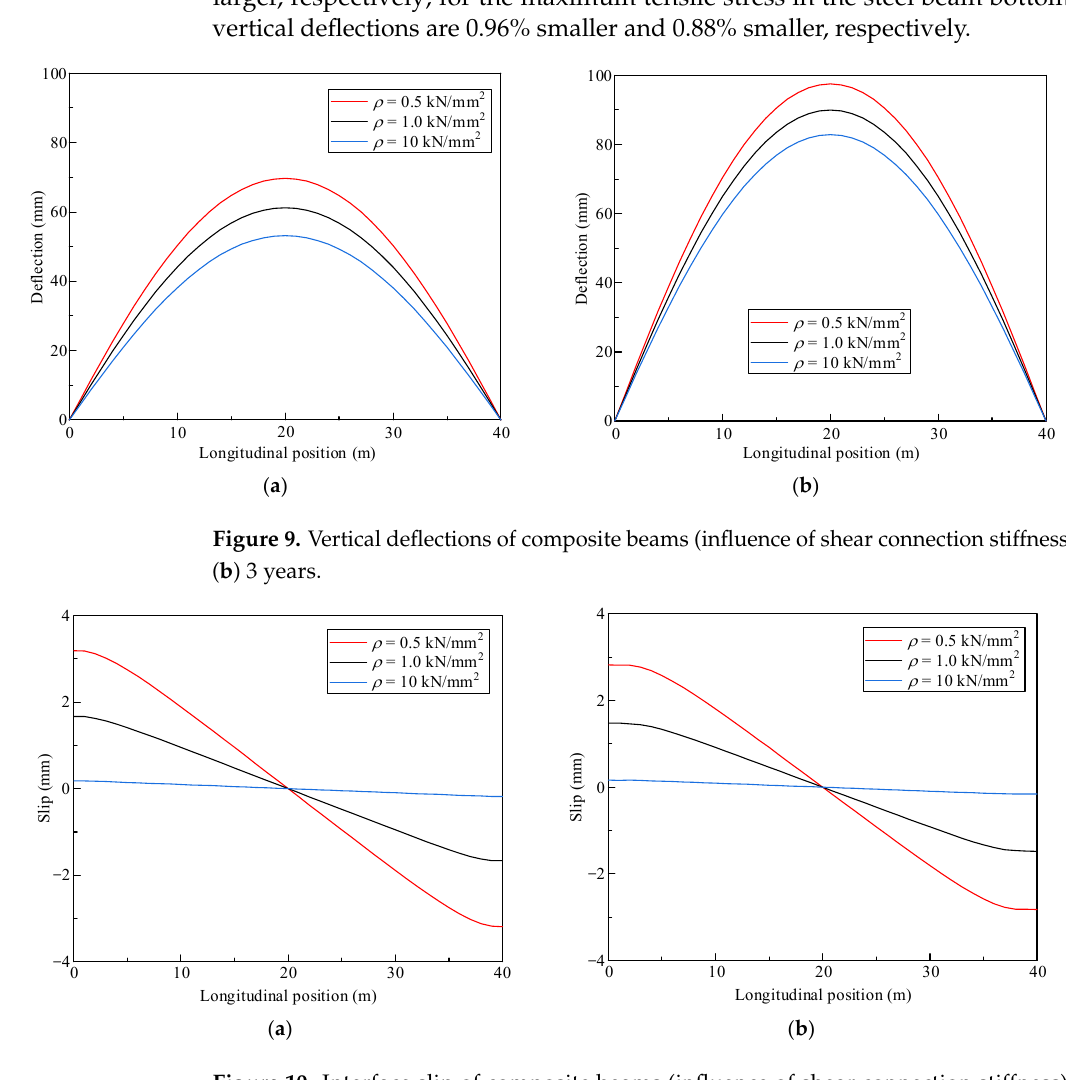
Figure 10. Interface slip of composite beams (influence of shear connection stiffness). ( a ) 28 days; ( b ) 3 years.